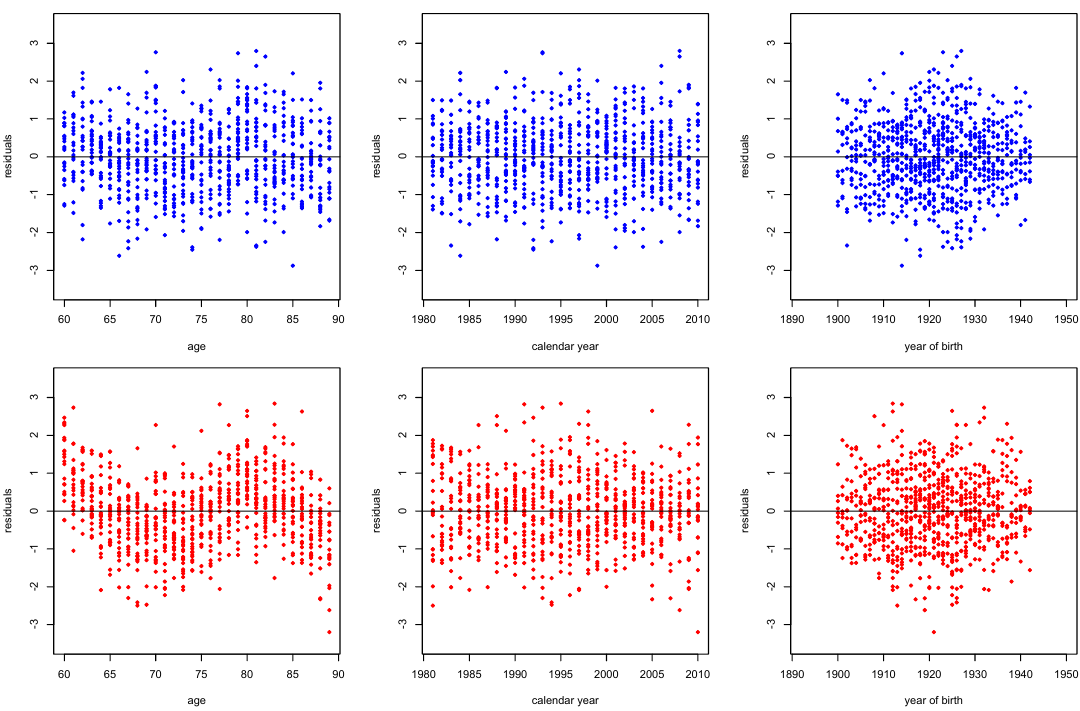
Figure 13. Residuals deviance of M 6 for males ( top panels) and females ( bottom panels) in Greece. Period 1981–2010, ages 60–89.